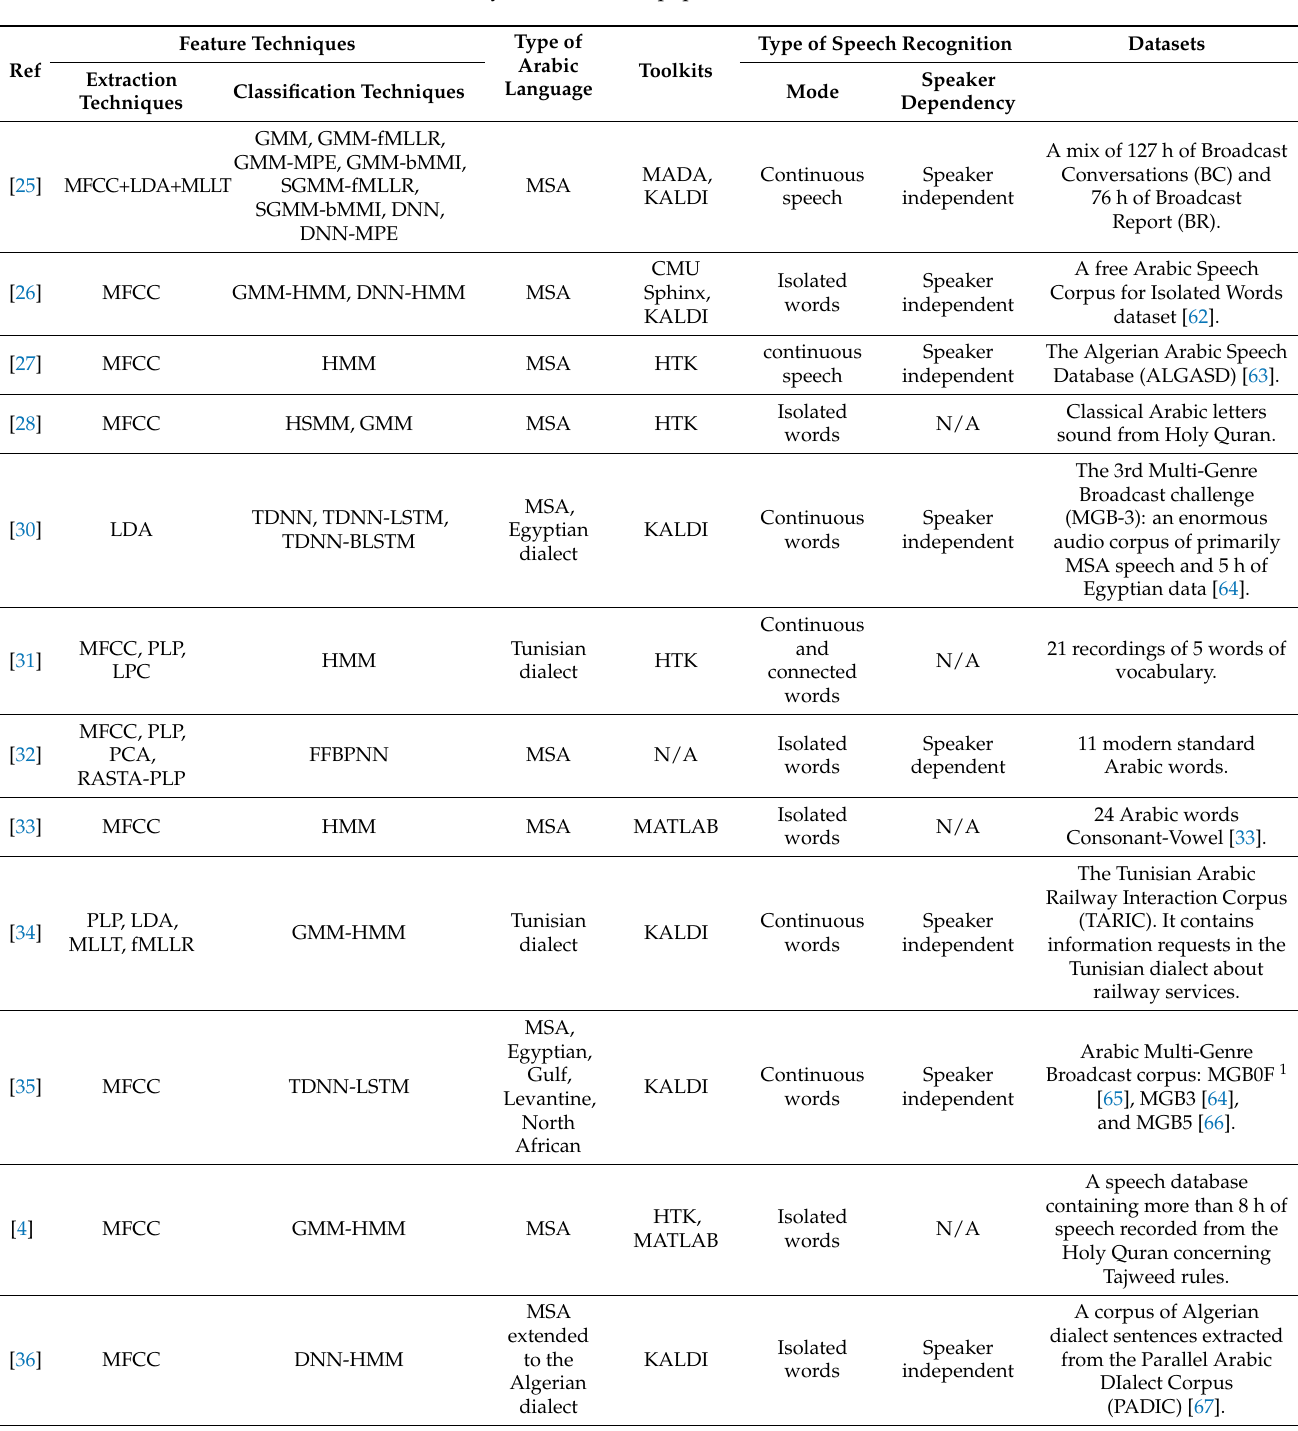
Table 6. Summary of the retained papers and their